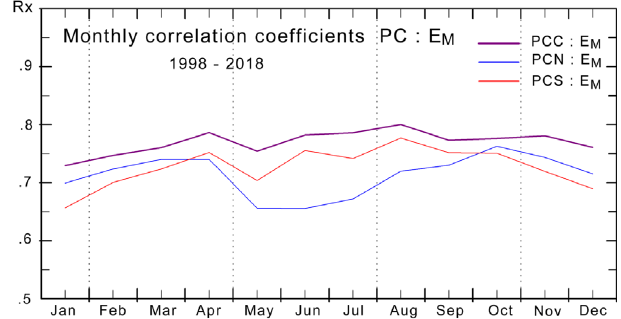
Fig. 6. Display of monthly average coef fi cients for the correlation between E M and PCN(blue line), PCS (red), and